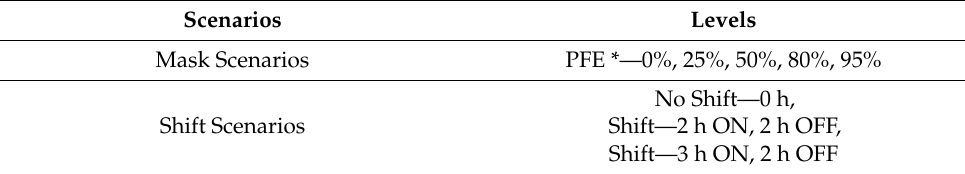
Table 1. Scenario variables and their